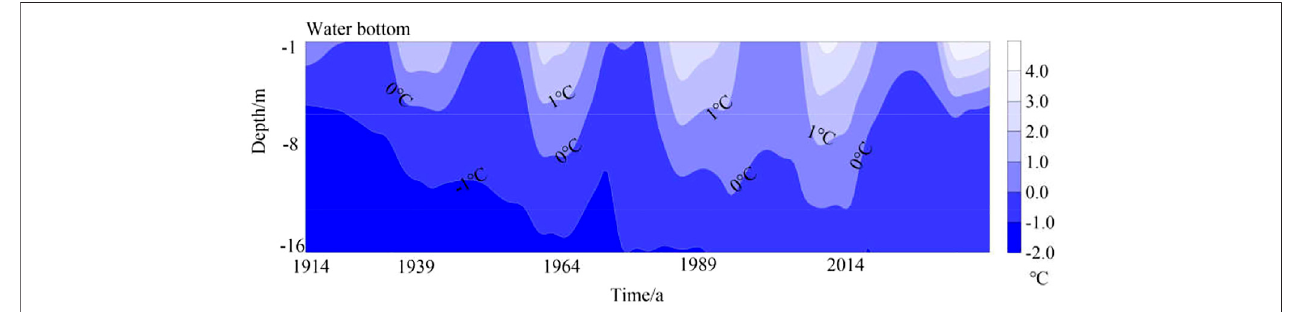
FIGURE 7 | Variations of ground temperature under the accumulated water in years 1914, 1939, 1964, 1989, and 2014 during the calculation time.